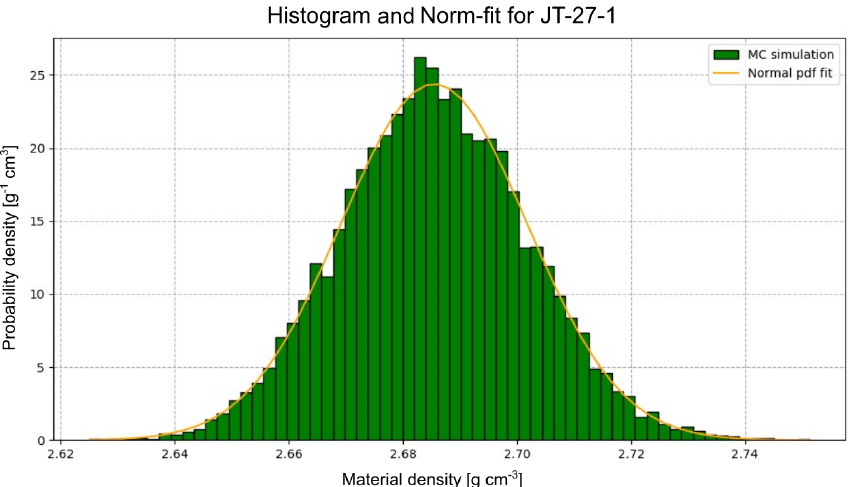
Figure B1. Example output of “subsample_ analysis.py” for a bulk density measurement of subsample JT-27-1 (see the Supplement for data). Green bars represent the histogram of 10000 Monte Carlo simulation draws. The orange curve indicates the fitted normal probability density function.